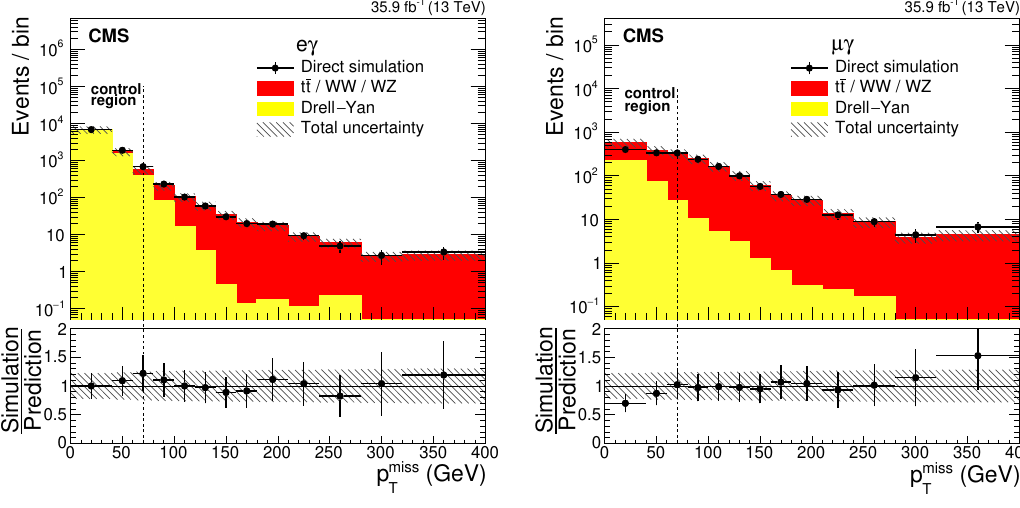
Figure 2 . Veri(cid:12)cation of the e-to- (cid:13) misidenti(cid:12)cation estimation method using simulated data. The p miss distribution for events with misidenti(cid:12)ed photons in the e (cid:13) (left) and (cid:22)(cid:13) (right) channels from T prediction using the control sample estimation method (histograms) and direct simulation (points), as obtained from the generator-level information of the simulated data. The vertical bars on the points show the statistical uncertainty in the simulation, while the horizontal bars give the bin widths. The dashed vertical line shows the boundary between the control and signal regions. The lower panels show the ratio of the predictions from direct simulation to those estimated with control samples. The hatched areas give the quadrature sum of the statistical and systematic uncertainties in the simulated